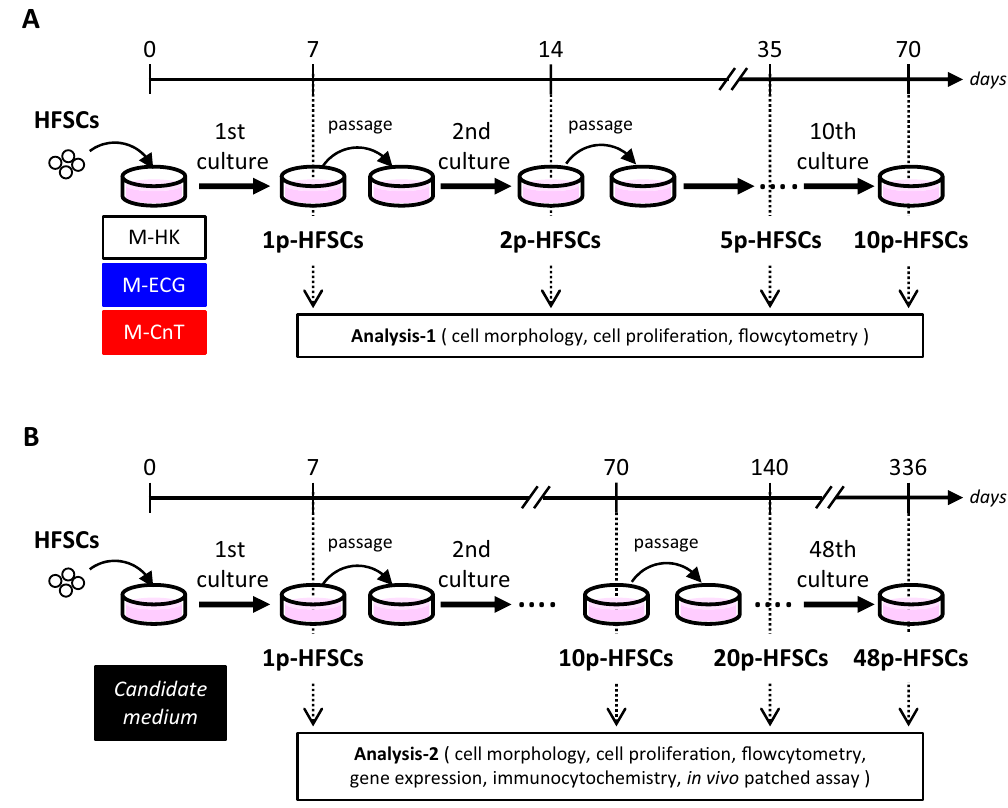
Figure 1. Analysis of short- and long-term cultured HFSCs. ( A ) HFSCs were cultured with various types of serum-free medium (M-HK, M-EcG, M-CnT) for a short term (10 passages), then a candidate medium was selected. ( B ) HFSCs were cultured with the candidate medium for a long term (48 passages) and subjected to various